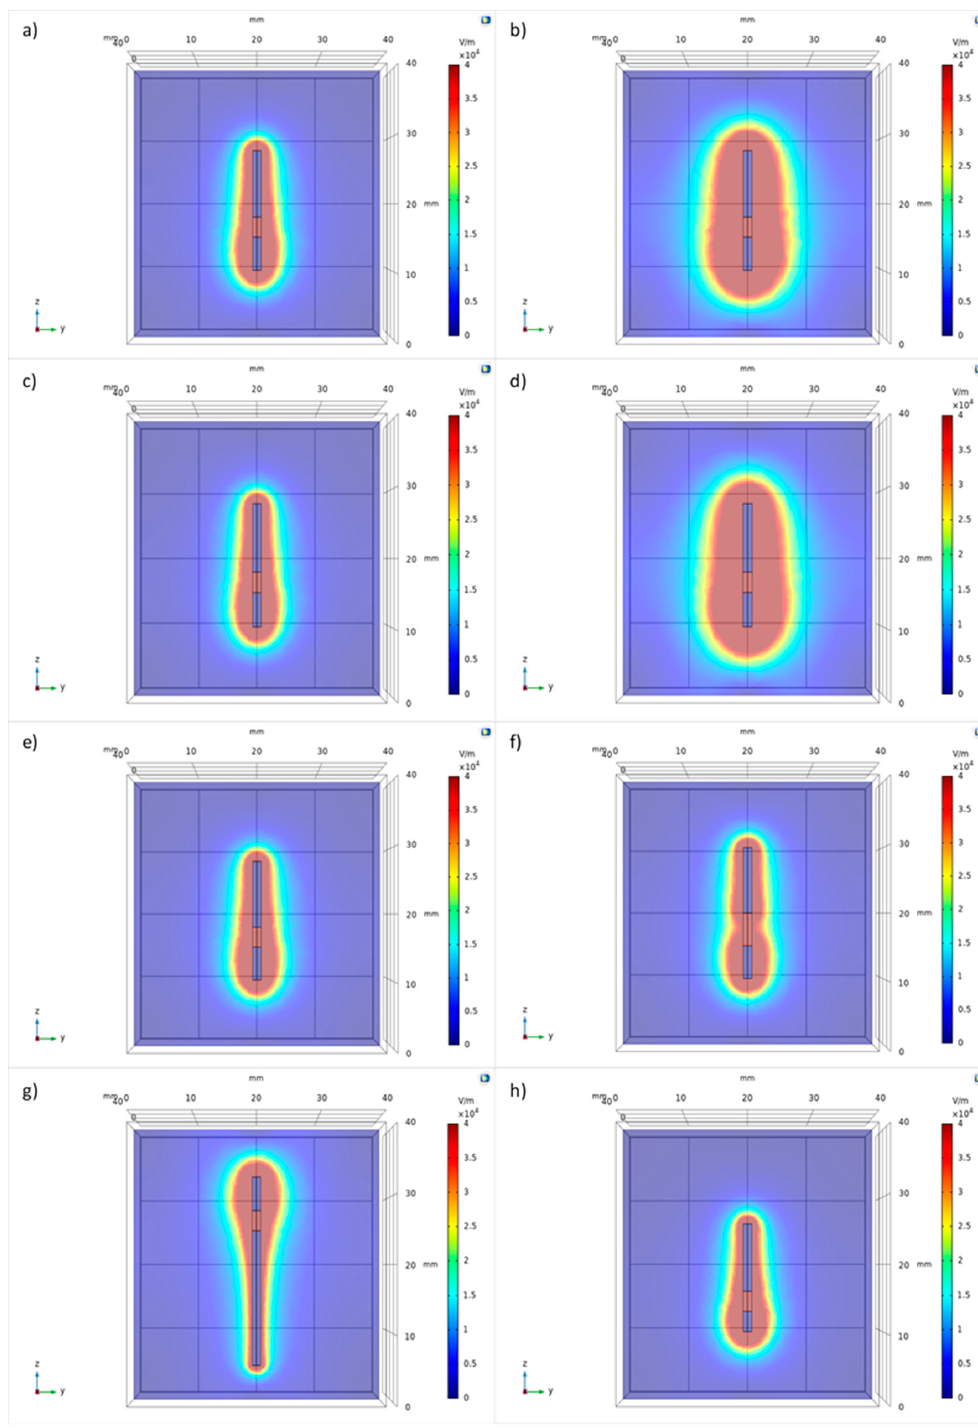
Figure 3. Comsol Multiphysics ® simulation: The electric field distribution considering a voltage of 500 V in ( a ) and of 1500 V in ( b ). The electric field distribution due to an electrode’s diameter of 1.40 mm and a voltage of 500 V in ( c ) and a diameter of 1.50 mm and a voltage of 1500 V in ( d ). Insulated pole of 3.0 mm in ( e ) and of 5.0 mm in ( f ). P1 = 20.00 mm and P2 = 5.00 mm in ( g ), P1 = 3.00 mm and P2 = 10.00 mm in ( h ). The color bar represents the intensity of the electric field distribution: in red is the highest value of electric field of the electroporated zone that decreases when moving away from the poles of the electrode.